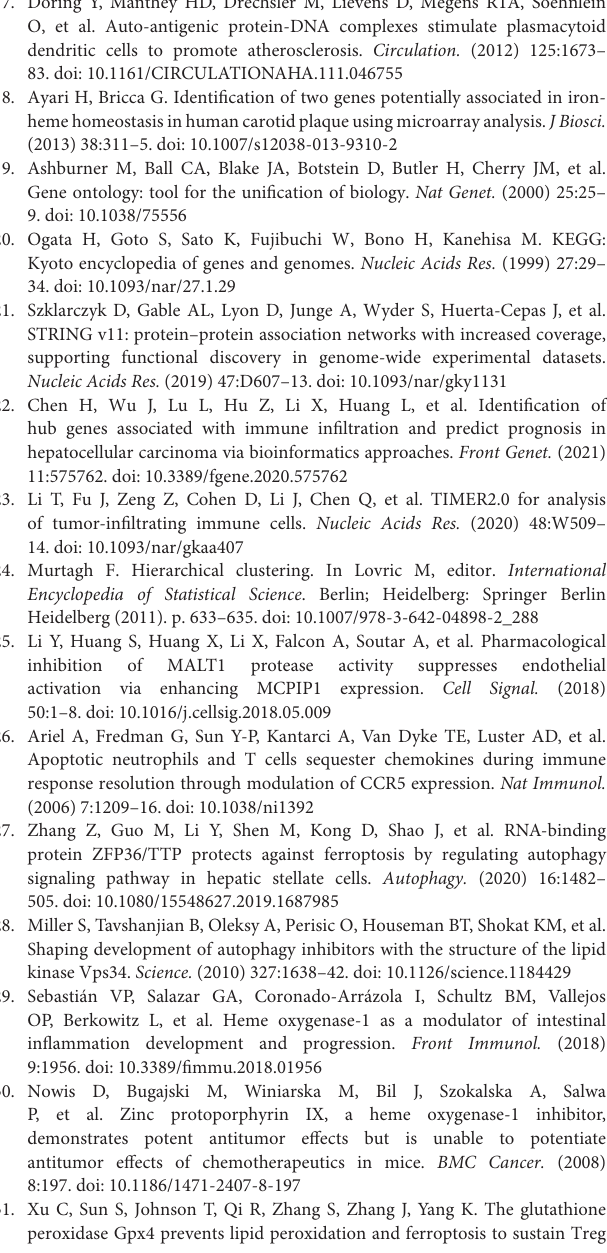
Supplementary Table 1 | Seventy ferroptosis-related genes (FRGs) obtained from GeneCards. Supplementary Table 2 | Primers pairs for genes expression